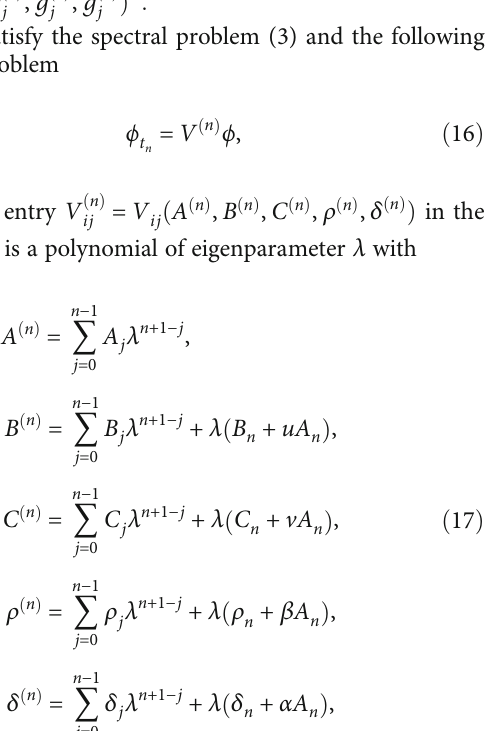
u ffiffiffiffiffiffiffiffiffiffiffiffi